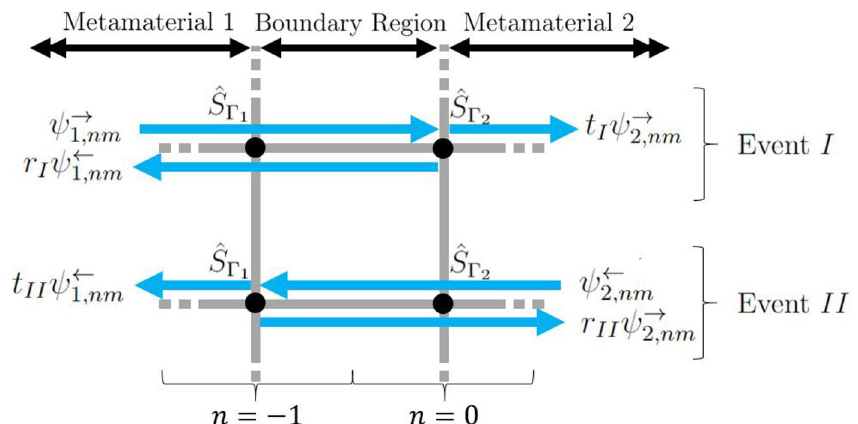
1 and all = − p and t p